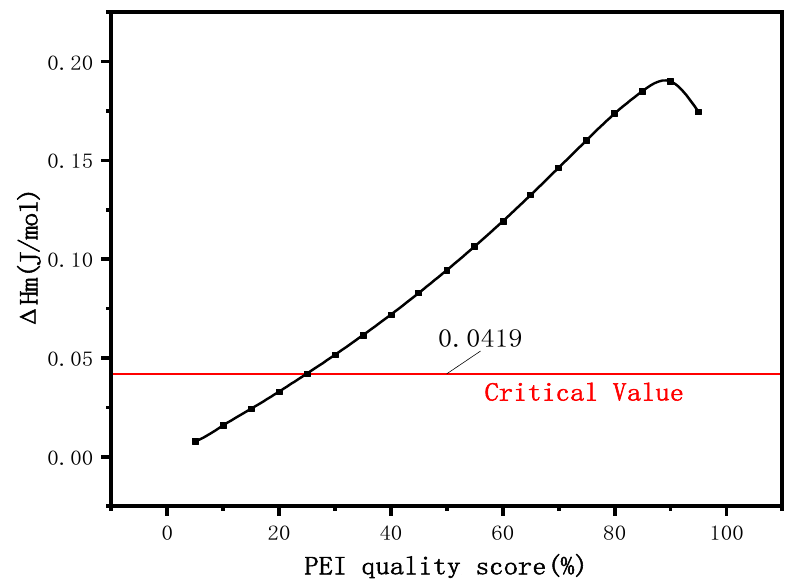
Figure 10. Enthalpy change of PVDF/PEI blend membrane.